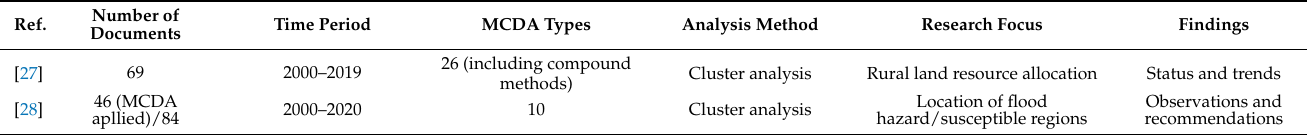
Table 1. Summary of existing related reviews based on the MCDA